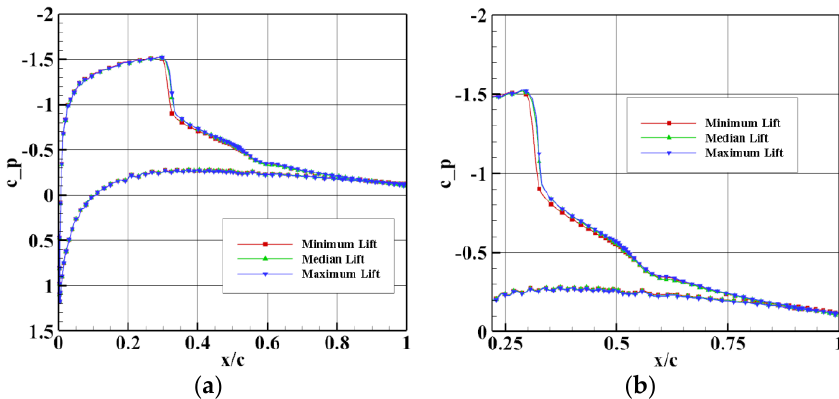
Figure 21. Pressure distributions over the airfoil for the “46% x/c” case at an incidence angle of 6.0°. ( a ) Surface pressure distribution; ( b ) zoomed version.